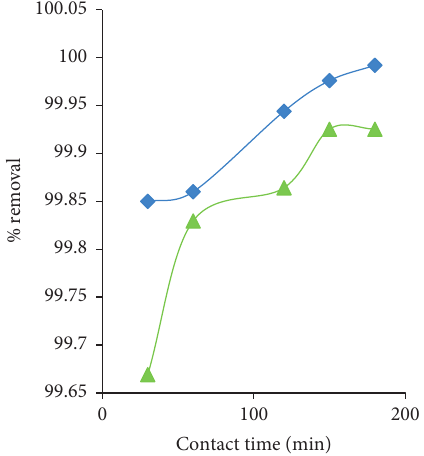
Figure 8: % removal of Cd (II) ions versus contact